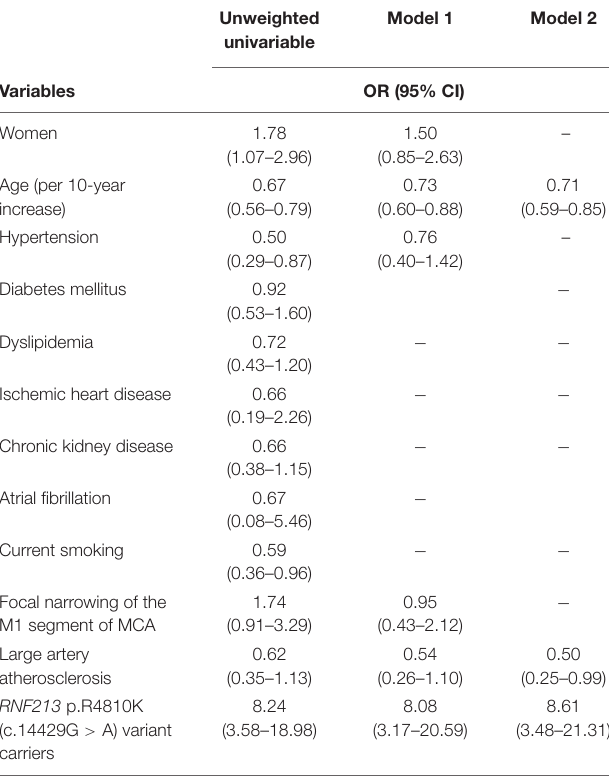
TABLE 3 | Logistic regression analyses for the presence of both PComAs.